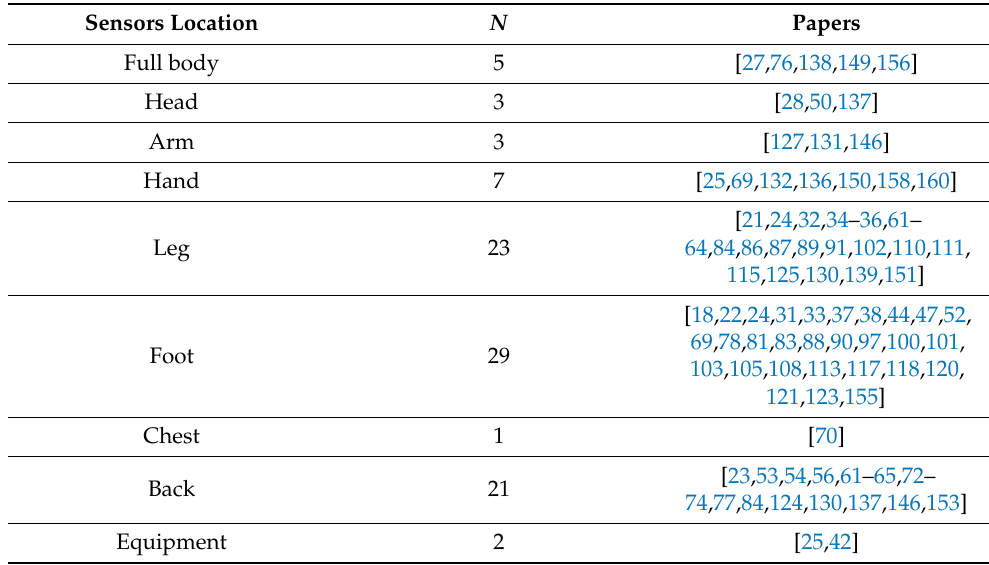
Table 4. Wearable sensor placement on the user’s body or equipment. Papers with sensors that are not wearable are not included in the